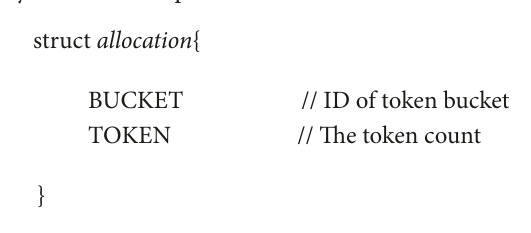
Algorithm 1 is the pseudo code for the first allocation. Lines starting with // are comments and all the other lines are valid code. The number at the beginning of each line is the line number. The input of the algorithm is the generated ) and the output is the first token allocation tokens ( L token policy ( L allocation